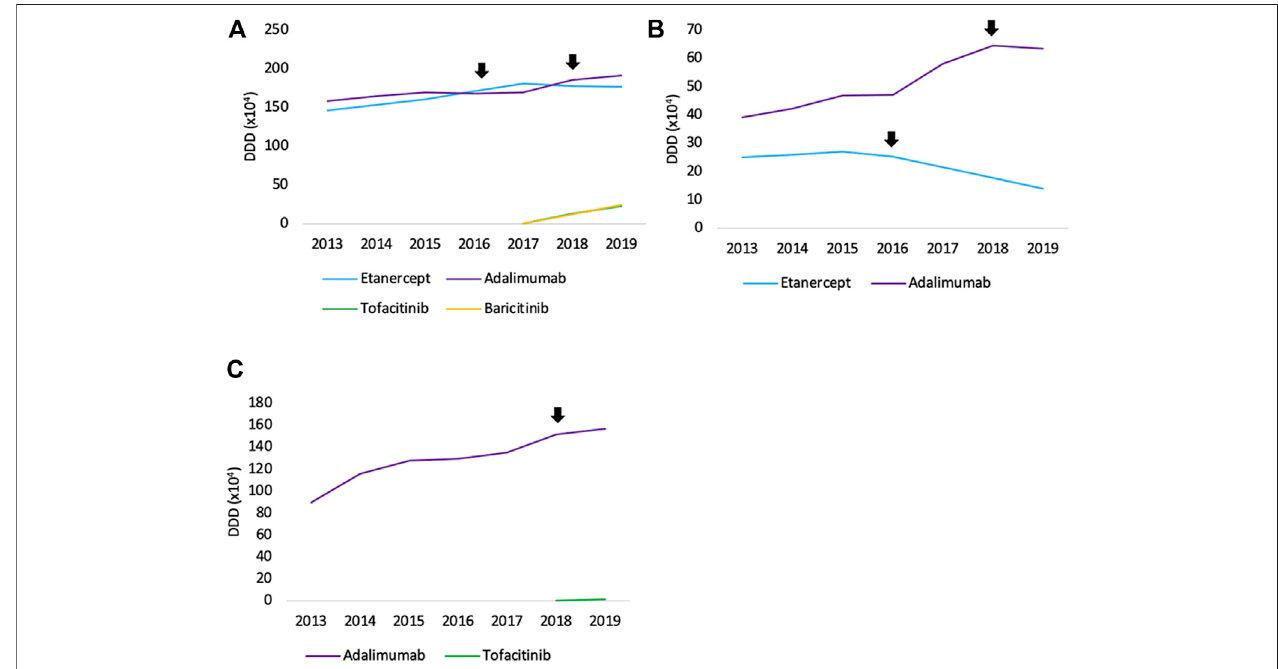
FIGURE 2 | Total volume (DDD) evolution of SC off-patent TNF- and JAK inhibitors per therapeutic area between 2013 and 2019 for (A) rheumatology (B) dermatology, and (C) gastroenterology. Arrows indicate the date of fi rst biosimilar market entry.